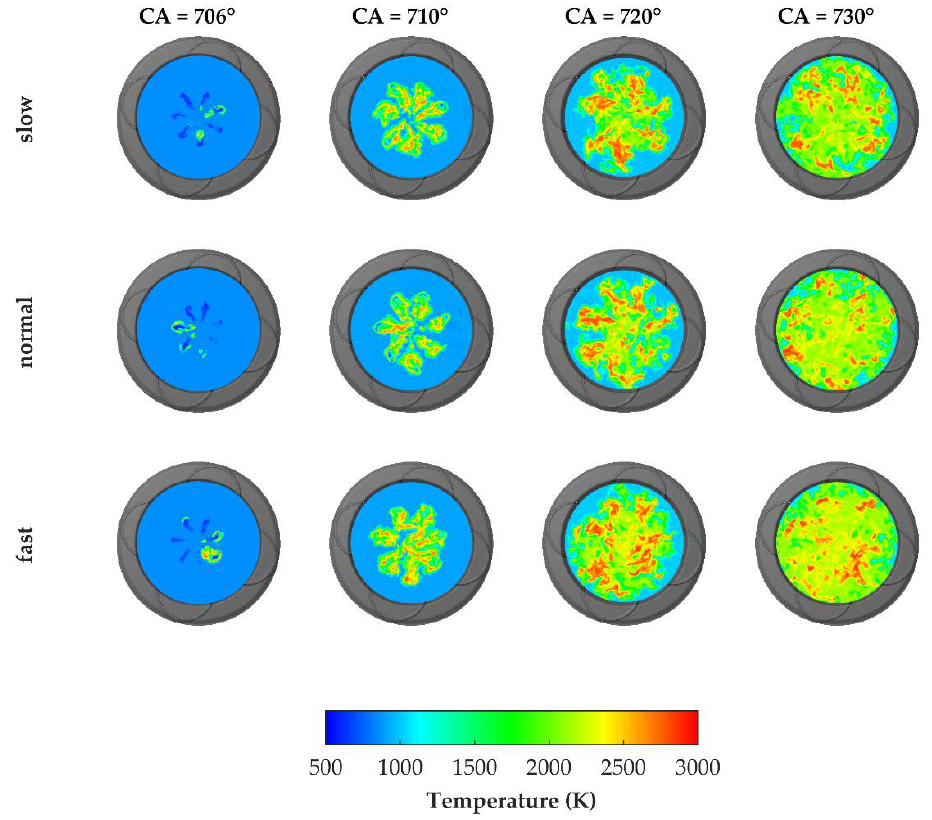
Figure 17. Conical surface through the spray plumes representing the temperature field for three different fast-burning cycles at four different crank angles.